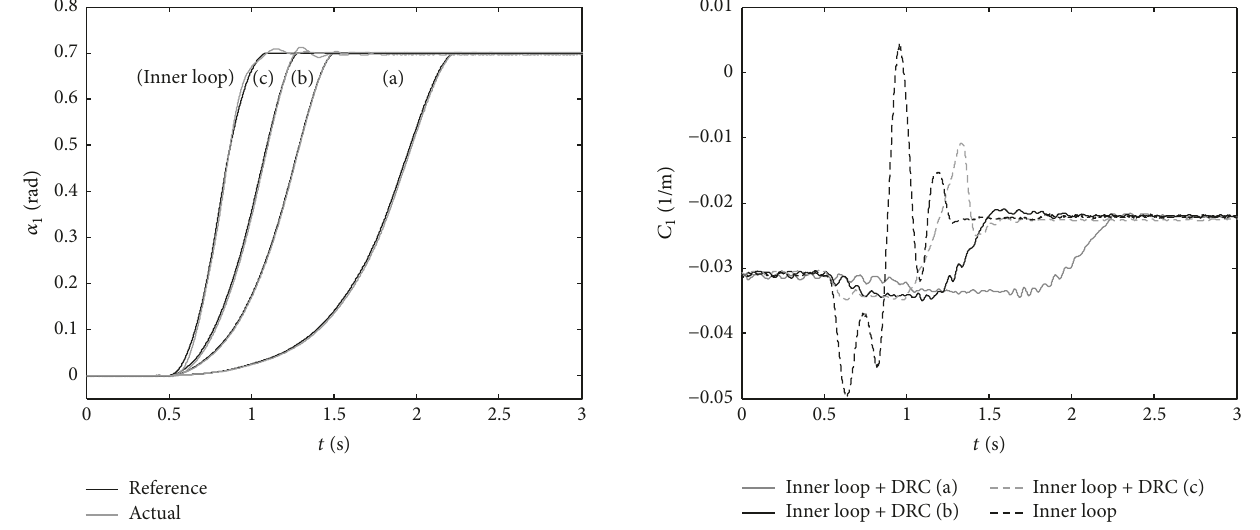
Figure 6: Comparison of the crank strains.